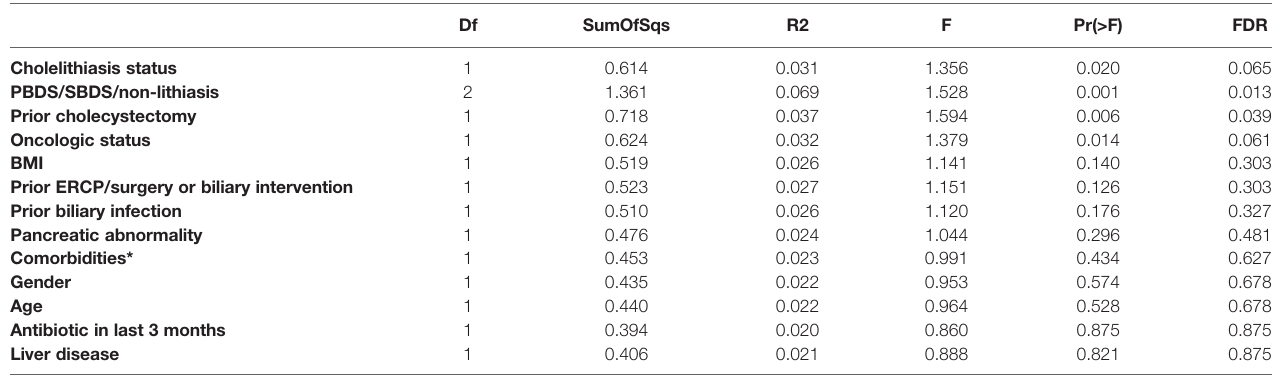
TABLE 1 | PERMANOVA based on unweighted UniFrac distance of different clinical information. Df SumOfSqs R2 F Pr(>F) FDR